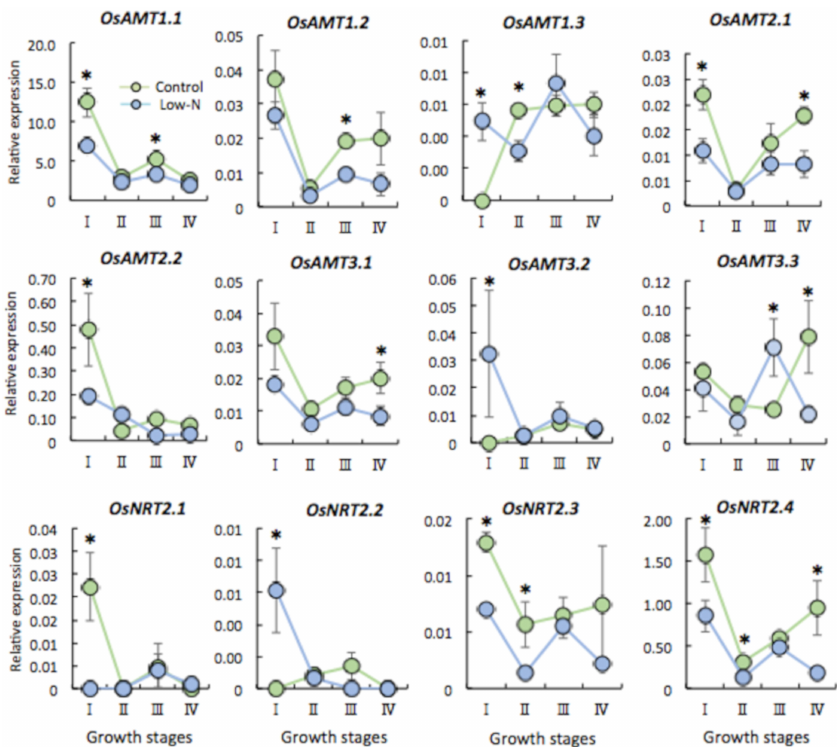
Figure 3. Relative expression of N transporter genes (NH 4 + transporter genes, AMT; NO 3 − transporter genes, NRTs) in leaves. I, II, III, IV refer to before and after topdressing at tiller initiation and early panicle formation stages. Each point represents the mean value, error bars indicate mean ± SD of 5 replicates. * Significant di ff erence ( p < 0.05, Student’s t